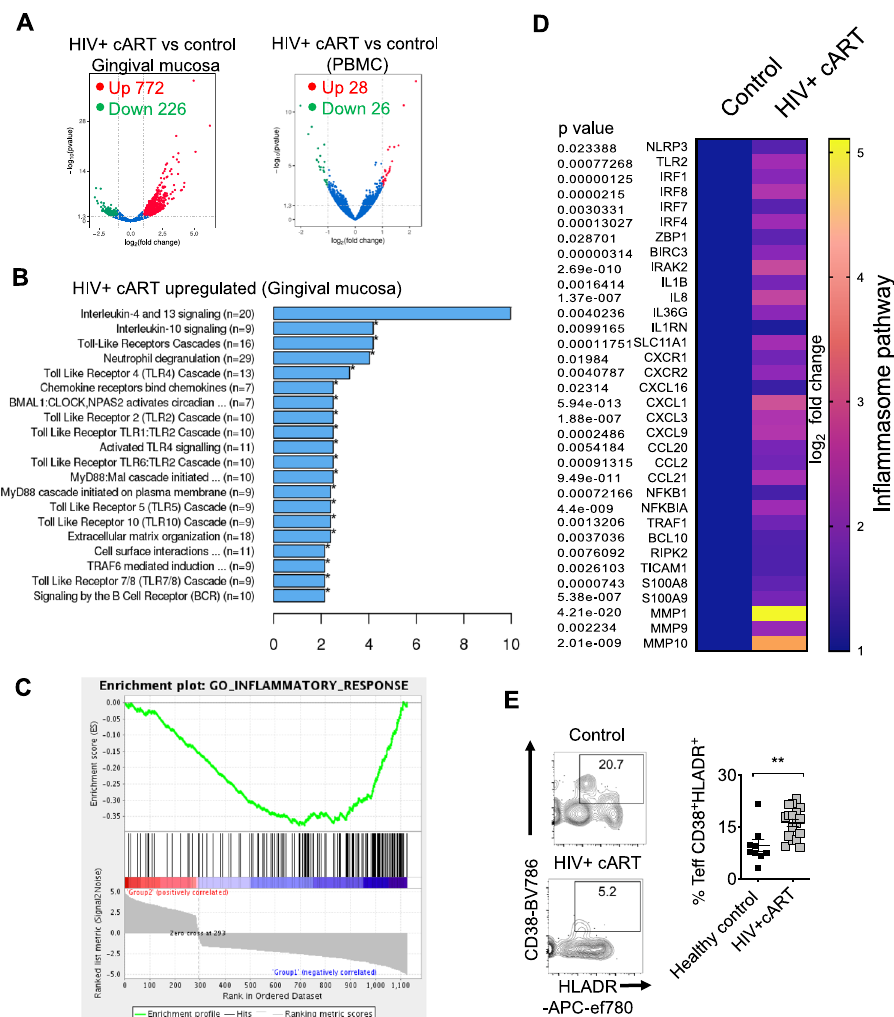
Fig. 1 Transcriptomic pro fi ling and fl ow cytometric analysis of oral mucosa in HIV + patients. Forty-six HIV + patients on cART treatment and 32 uninfected healthy controls were recruited (Supplementary Table 1). RNA sequencing was performed in gingival tissues and PBMCs collected from six randomly chosen age-matched participants; healthy uninfected control ( n = 3) and HIV + cART ( n = 3), 2 males and 1 female in each group. Gingival cells were enriched for immune cells by reducing the epithelial cells through gradient centrifugation before transcriptome analyses. Volcano plots showing differential RNA expression in HIV + cART versus healthy uninfected control groups in gingival mucosa ( A , left) and PBMCs ( A , right). B REACTOME pathway analysis of the genes upregulated in HIV + cART gingival mucosa. C Gene set enrich analysis (GSEA) was performed using the GSEA software (Broad Institute; http://www.broad.mit.edu/GSEA) employing the entire gene list generated from transcriptome analyses. This whole gene list was pre- ranked based on T Score and then uploaded to GSEA software. In fl ammatory response signature genes were de fi ned based on the gene sets in MSigDB. D Heatmaps showing upregulation of in fl ammasome signature genes that were de fi ned based on the published literature. Human oral intraepithelial and lamina propria leukocytes (HOILs) from gingival biopsies were processed for fl ow cytometry. E Effector CD4 cells were gated as shown in Supplementary Fig. 1B and further on FOXP3-negative population. Contour plots (left) and statistics (right) showing the percentage of activated (CD38 + and HLADR + ) effector CD4 + cells ( n = 20); mean value ± SEM are plotted. (** P = 0.0029; two-tailed; Mann – Whitney test). Source data are provided as a Source data fi